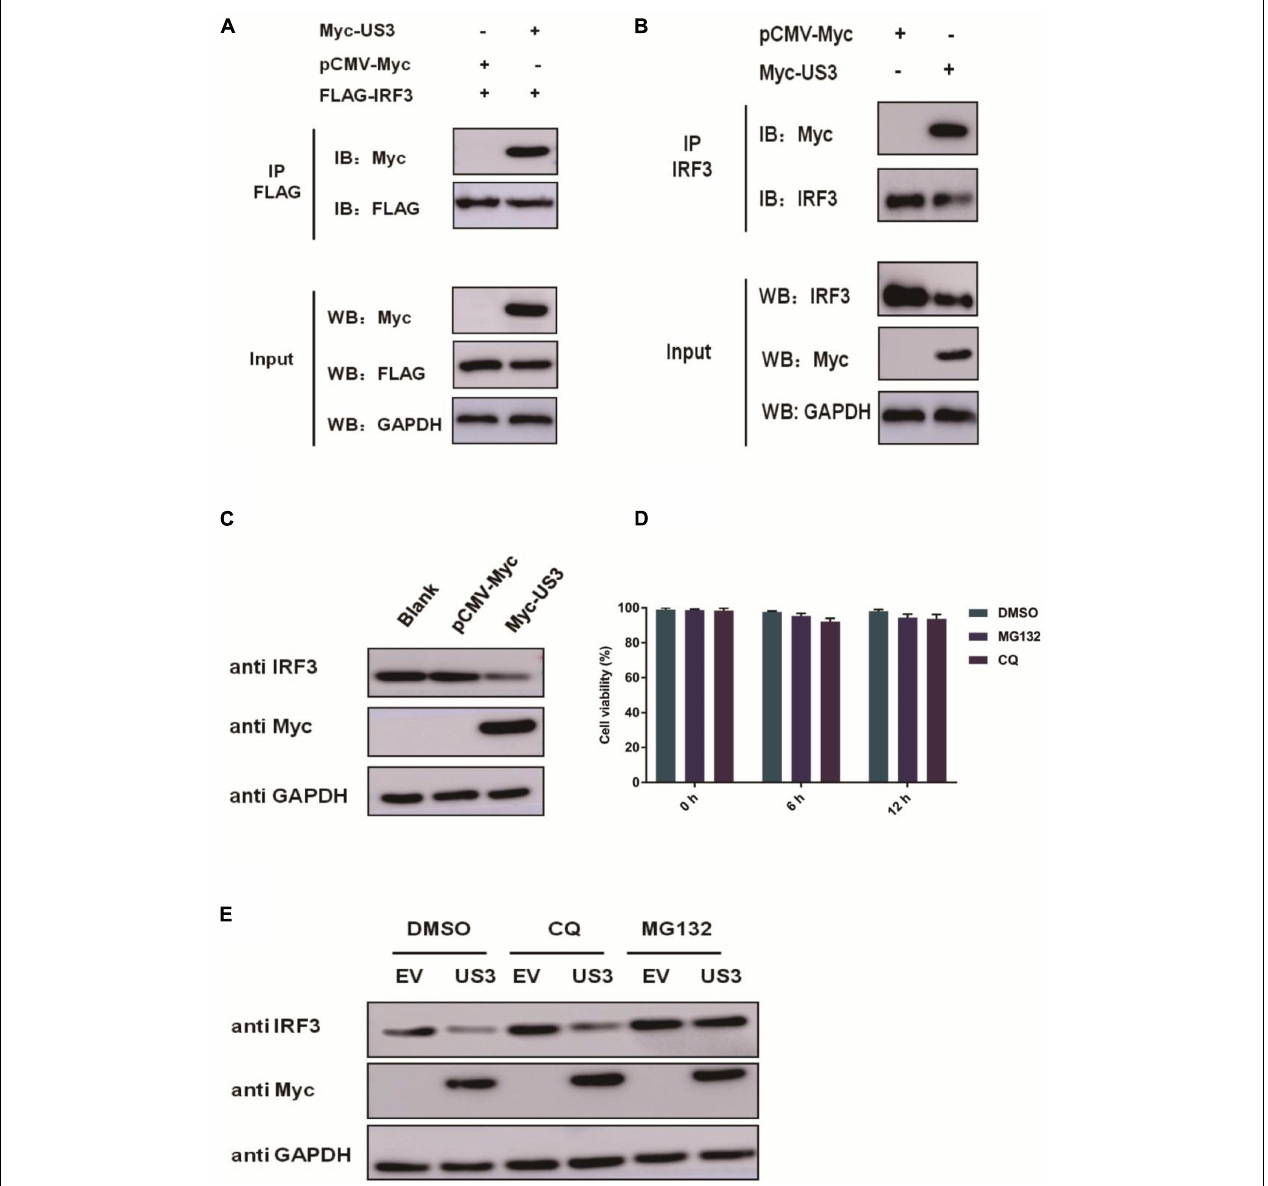
FIGURE 3 | (A) PK15 cells were co-transfected with empty vector (0.5 µ g) or Myc-US3 (0.5 µ g) plasmids and FLAG-IRF3 (0.2 µ g) plasmids for 30 h. The cells were then lysed and immunoprecipitated with an anti-Flag antibody. The whole-cell lysates (input) and immunoprecipitation (IP) complexes were analyzed using an anti-Myc, anti-FLAG or anti-GAPDH antibody by western blotting. (B) PK15 cells were transfected with empty vector (0.5 µ g) or Myc-US3 (0.5 µ g) plasmids for 30 h. The cells were lysed and immunoprecipitated with an anti-IRF3 antibody. The input and IP complexes were analyzed by western blotting using anti-IRF3, anti-Myc or anti-GAPDH antibodies. (C) PK15 cells were transfected with empty vector (0.5 µ g) or Myc-US3 (0.5 µ g) for 24 h, then cells were collected for western blotting using anti-IRF3, anti-Myc or anti-GAPDH antibodies. (D) Chemicals were previously tested for cytotoxicity at the concentrations used. PK15 cells treated with 7.5 µ M MG132 or 50 µ M CQ for 6 h and 12 h in 96 well plate. Cell viability was determined using the CCK8 reagent. Data were expressed as the mean ± SD from three independent experiments. (E) PK15 cells were transfected with Myc-US3 (0.5 µ g) or empty vector (0.5 µ g) for 24 h, then treated with lysosomal inhibitor MG132 (7.5 µ M) or the lysosome inhibitor CQ(50 µ M)for 6 h. DMSO treated cells served as vehicle control. Then cells were collected and immunoblotting for IRF3 and Myc. GAPDH served as a loading control.